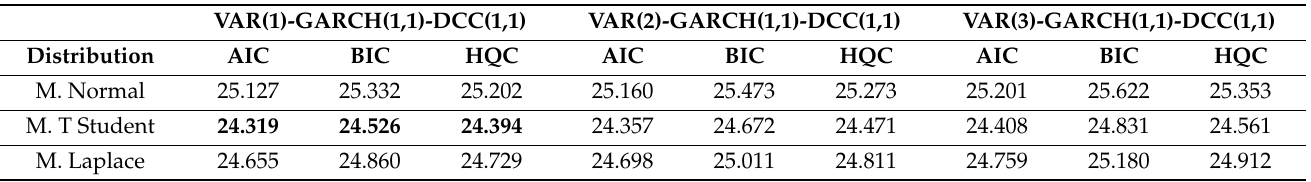
Table 2. Selection criteria with different multivariate distributions and VAR-GARCH-DCC models (the optimal model in bold print).